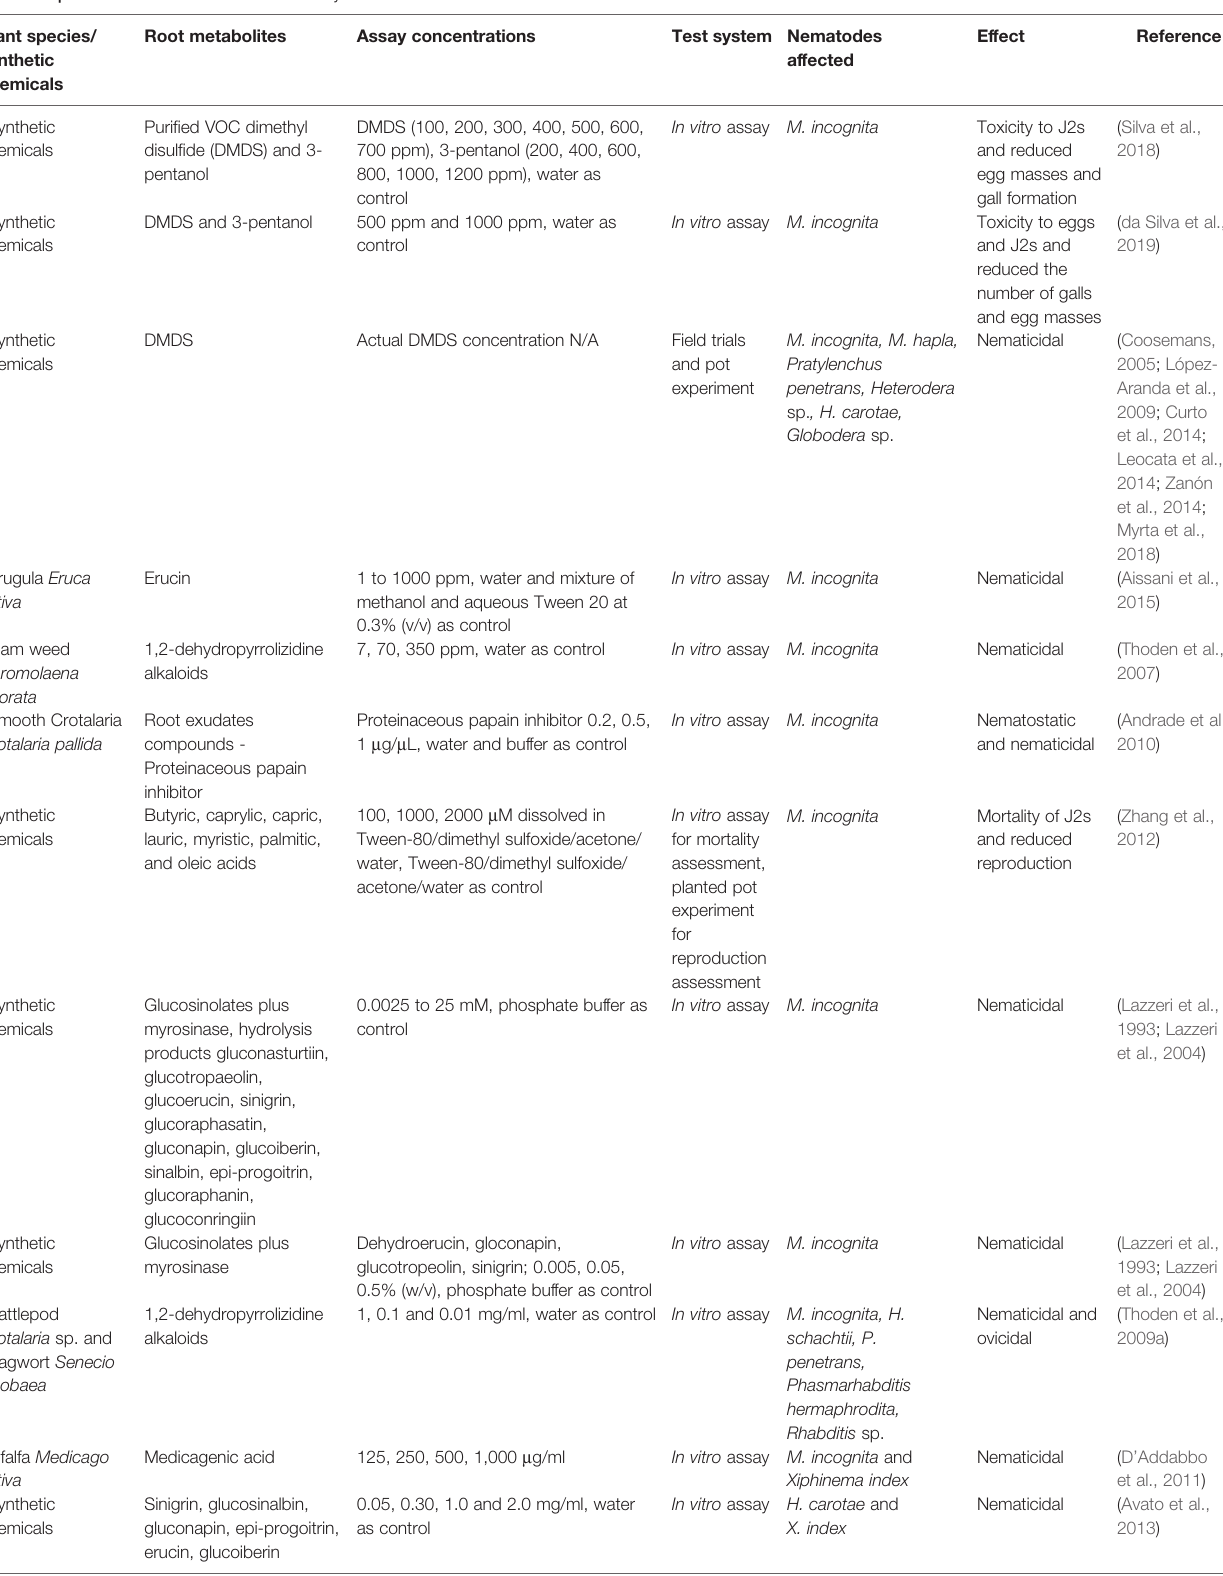
TABLE 2 | Nematicidal and nematode inhibitory root